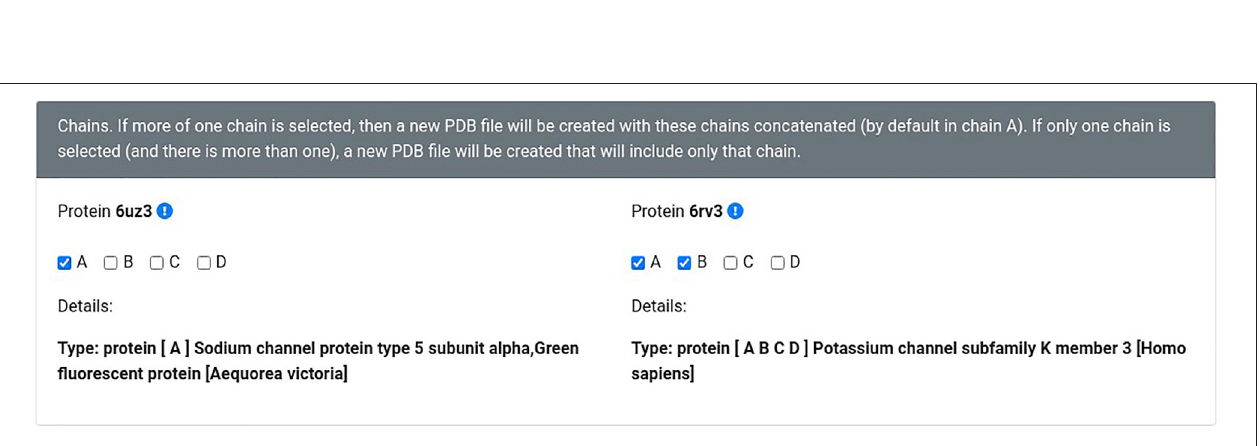
FIGURE 1 | The user may request the measures between two protein structures or within a list of pairs of proteins. Also, the protein structures can be both experimentally solved (downloaded from Protein Data Bank) or homology models (uploaded by the user).